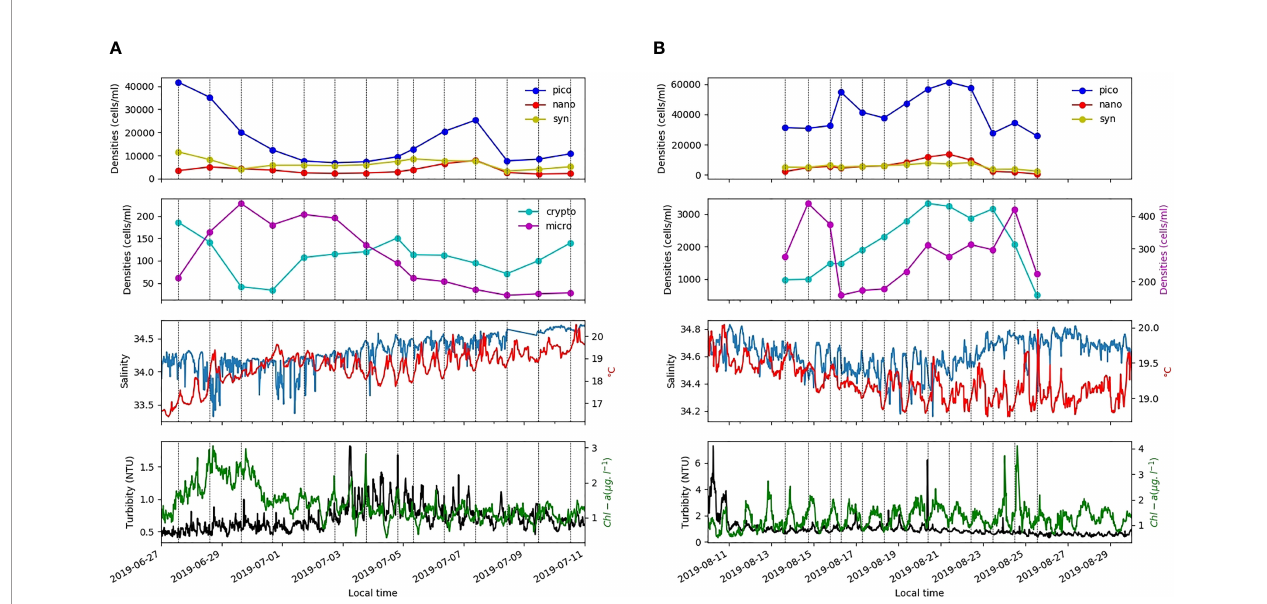
FIGURE 3 | Time series of variables obtained from the IFC and other sensors on the autonomous mooring in the Daoulas estuary (station C) from 28th June to 10th July 2019 (A) and from 13th August to 25th August 2019 (B) . Abundances of fi ve regular clusters ( Synechococcus , Picoeukaryotes, Nanophytoplankton, Microphytoplankton and Cryptophyceae) obtained from the IFC are plotted. IFC sampling was done at high water during the day (dotted vertical